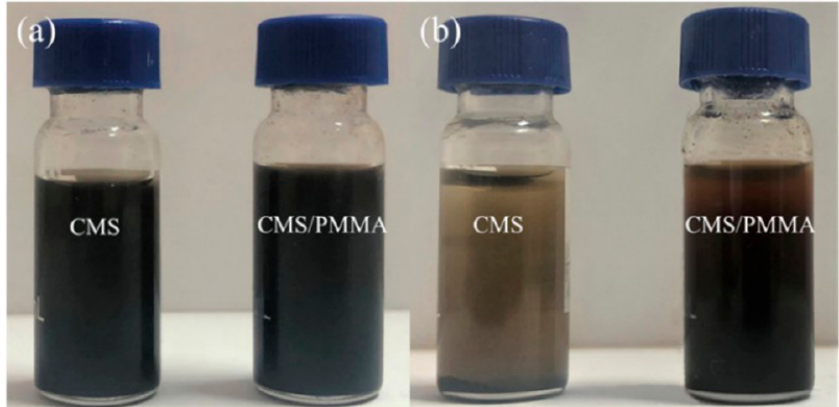
Figure 12. Digital pictures of carbon microspheres (CMS) and CMS/PMMA dispersions ( a ) immediately after sonication and ( b ) 8 weeks after sonication [80]. Reproduced with permission from [Yuefeng Gu et al.], [The Journal of Physical Chemistry C]; published by [American Chemical Society], 2019.